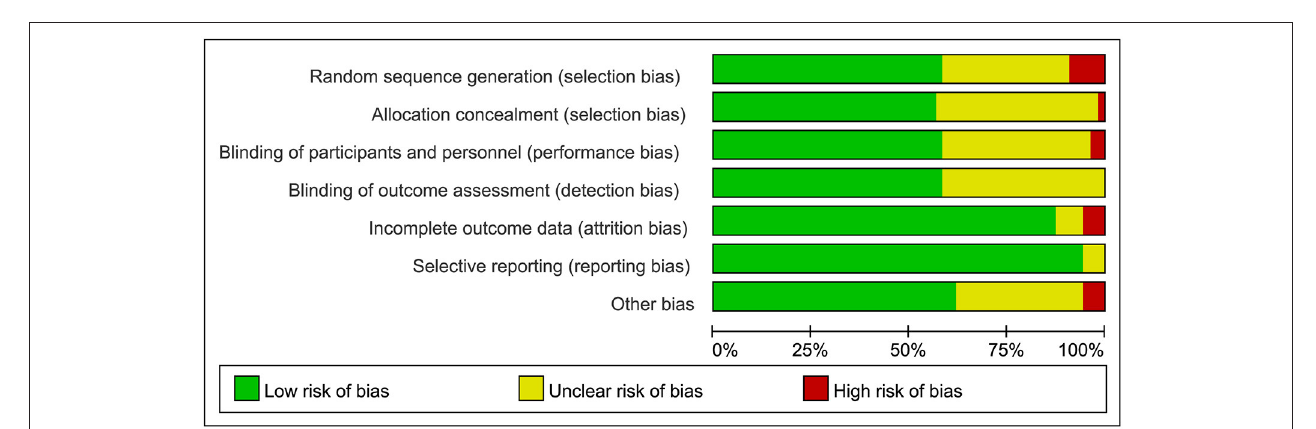
FIGURE 2 | Risk bias assessment graph for included